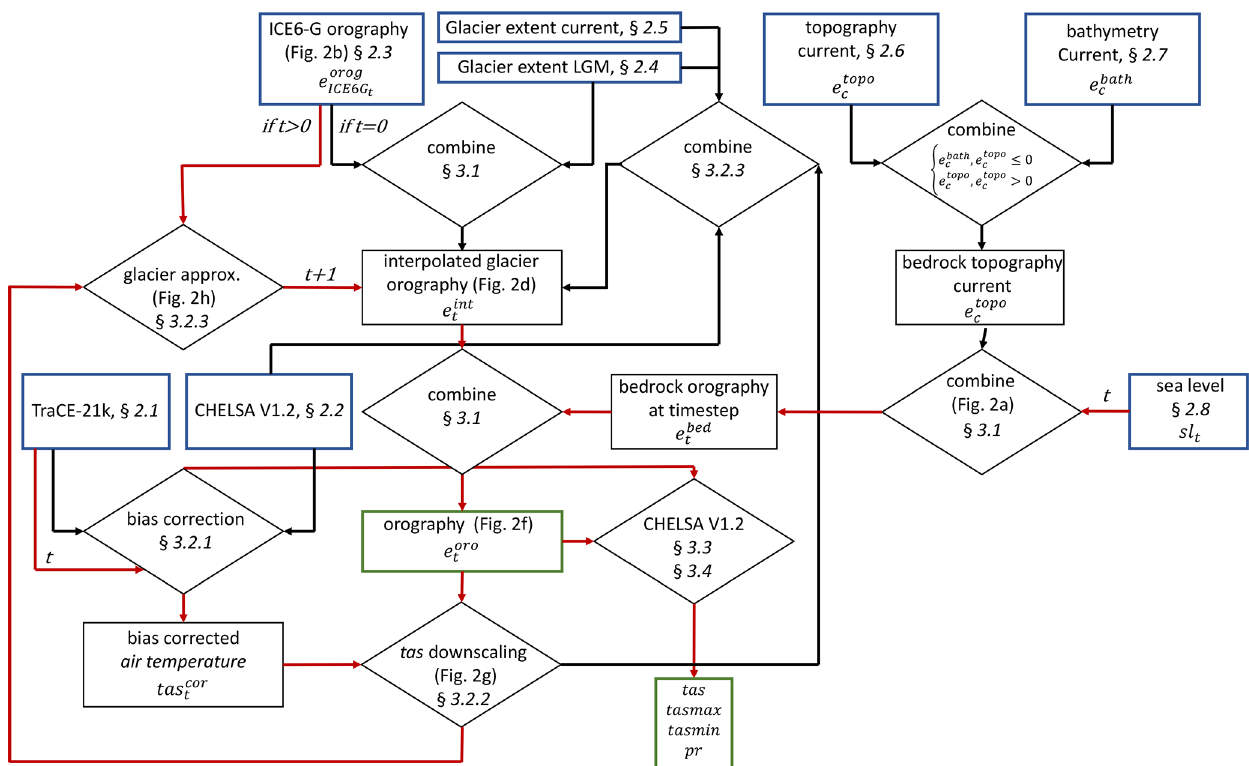
Figure 1. Graphical representation of the different steps employed in downscaling TraCE-21k simulations using the CHELSA V1.2 algo- rithm. Input datasets are indicated by a blue box; output data are indicated by a green box. Rhombi indicate processing steps; t indicates discrete time steps, with t = 0 being the LGM. Red lines indicate processing steps that are run iteratively over all time steps; black lines indicate computations that were run only